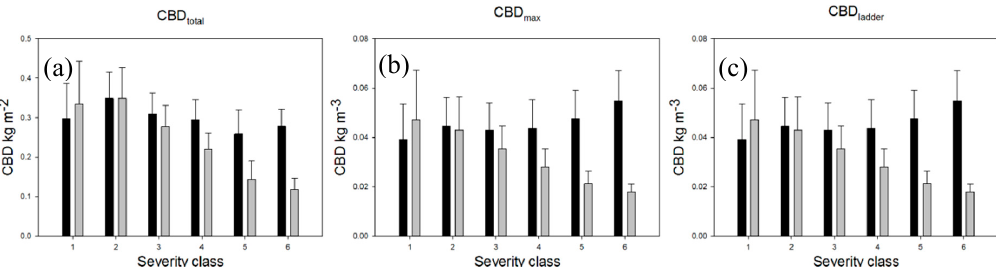
Figure 3 . Pre- and post-fire canopy fuels stratified by burn severity. Pre- (black) and Post- (gray) canopy fuel loading stratified by severity class for: ( a ) CBD total , ( b ) CBD max , and ( c ) CBD ladder . Bars represent the standard deviation of the distributions.